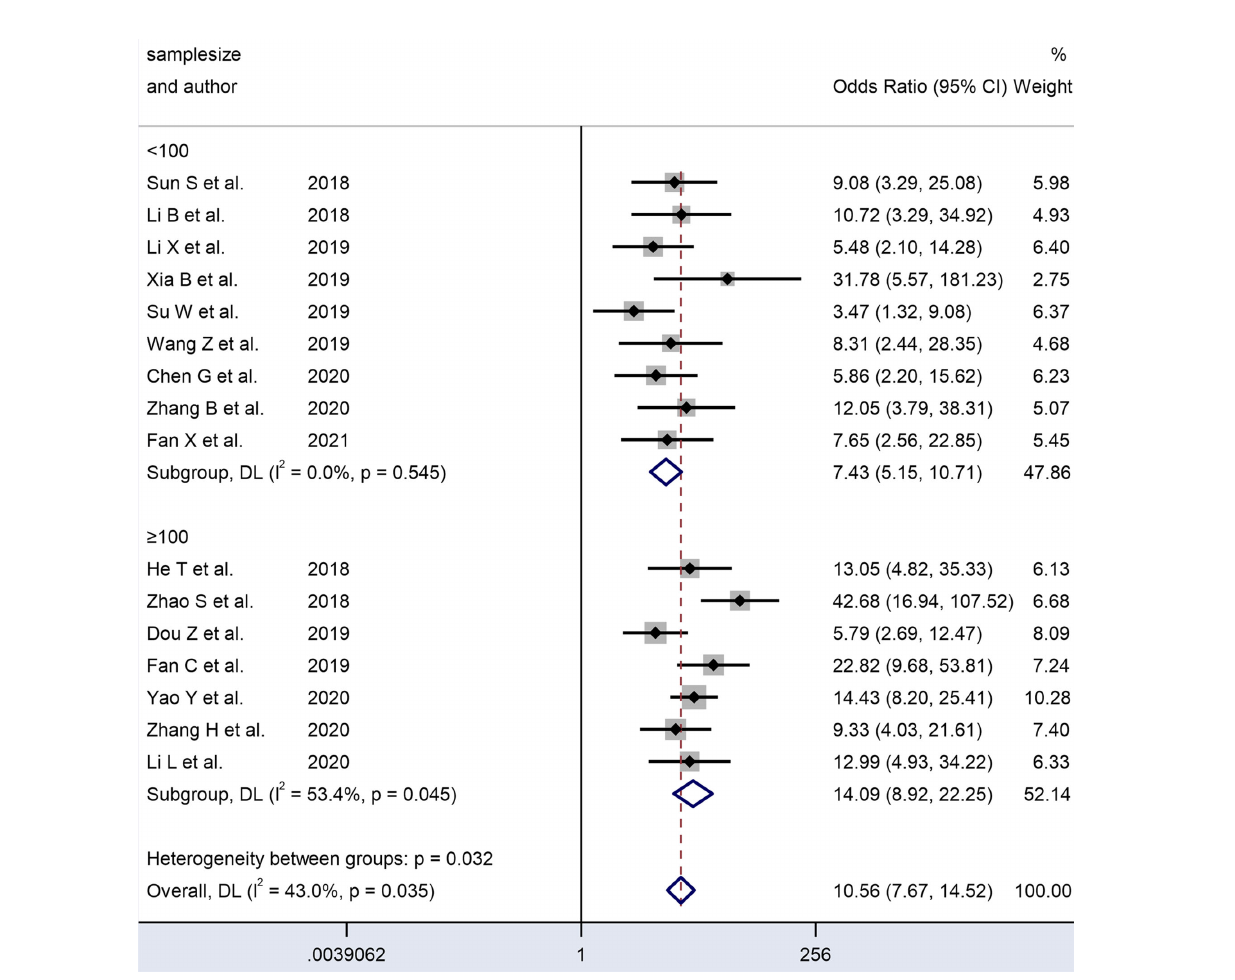
FIGURE 8 | Forest plots of subgroup analysis of the combined ORs with 95%CIs according to sample size of circRNAs in patients with OSCC.